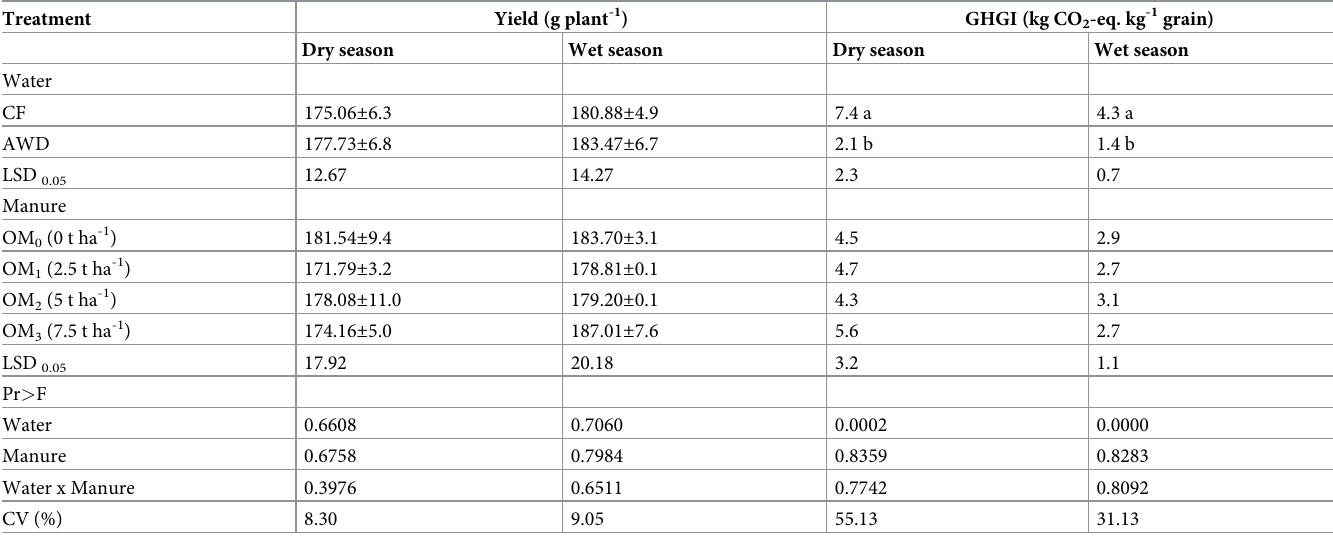
Within each column, values with different alphabets indicate significant differences among the treatments at 5% of LSD